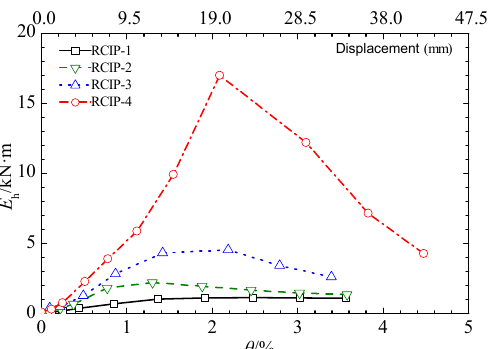
Figure 16. Comparison of single-cycle hysteretic energy at each loading level. The equivalent viscous damping ratio, ξ eq , is used to evaluate the hysteretic loop shape of a structure or component. Figure 17 shows the calculating diagram for the calculated equivalent viscous damping ratio, which is expressed as follows: